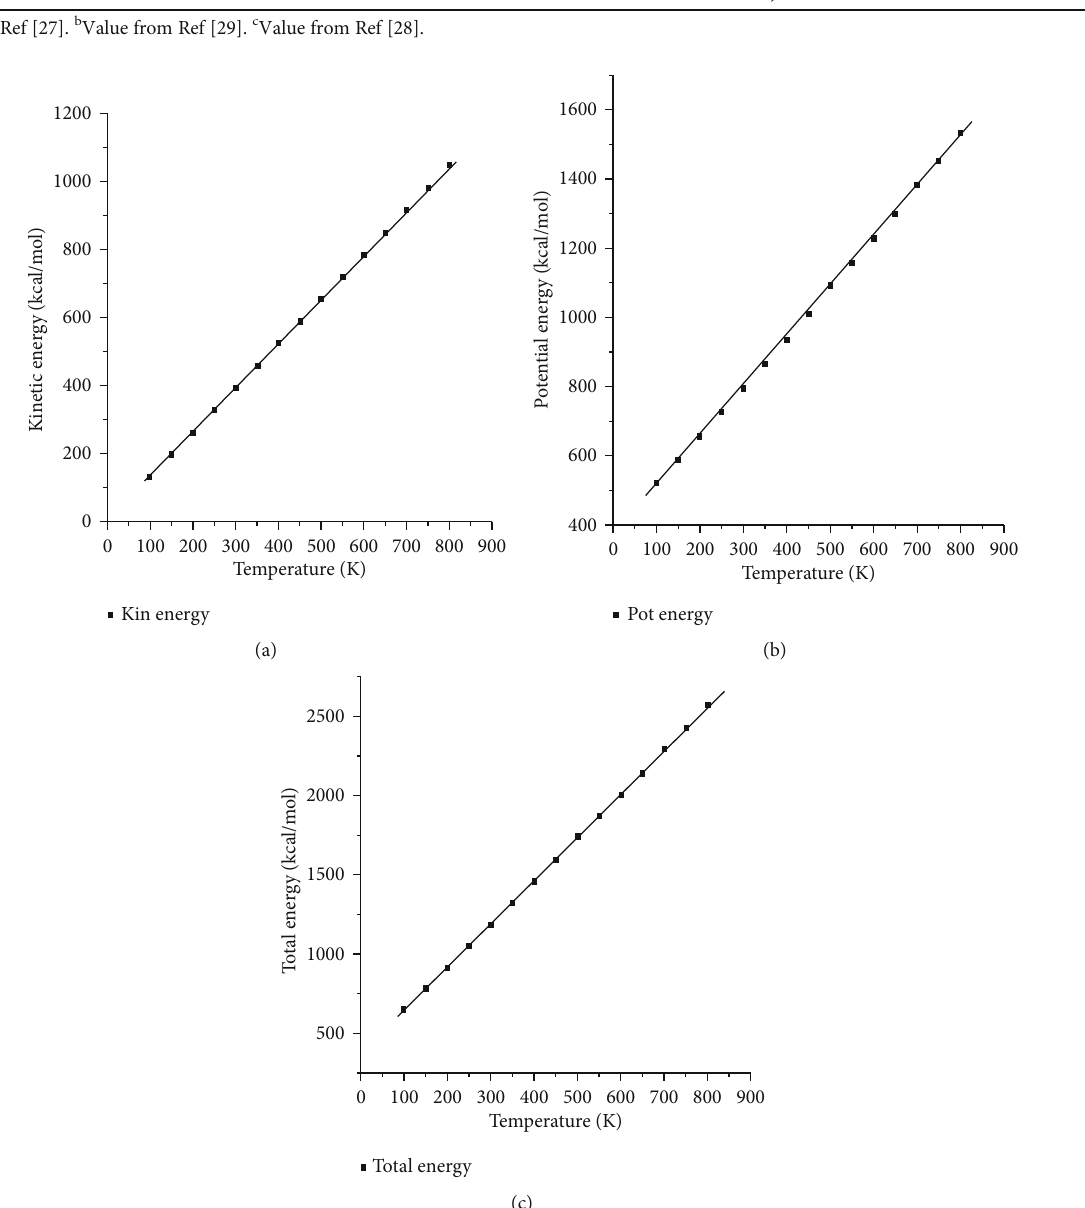
Figure 6: Curves of some energy components vs. temperature for the raw PET: (a) kinetic energy; (b) potential energy; (c) total energy.